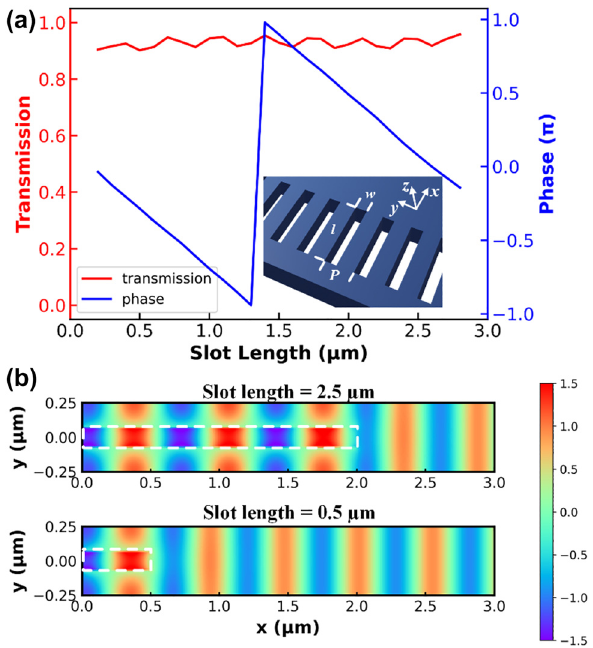
Figure 2: Design of the unit cell of the on-chip metamaterial. (a) Transmission and phase difference of metamaterial unit cell as a function of slot length. (b) Distribution of y component of electric field ( E center wavelength of 1550 nm with two different slot width of 0.5 μ m and 2.5 μ